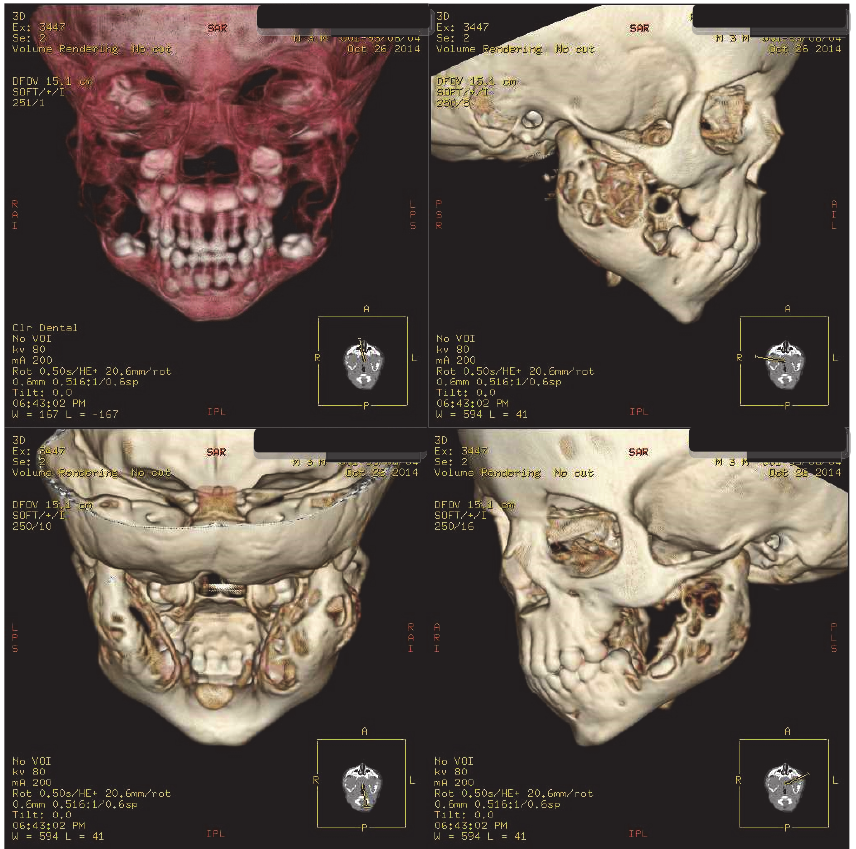
Figure 4: Three-dimensional images of the